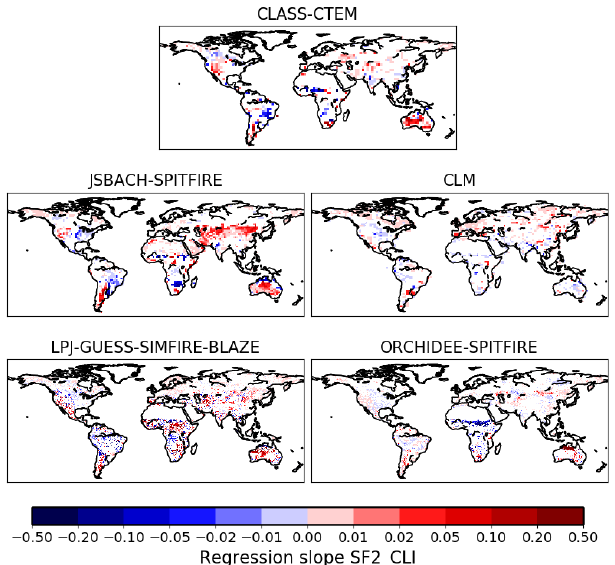
Figure A7. Spatial distribution of regression slopes for the difference between the baseline experiment SF1 and the sensitivity experiment SF2_CLI (SF1–SF2_CLI; see Table 1) over 1921–2013.